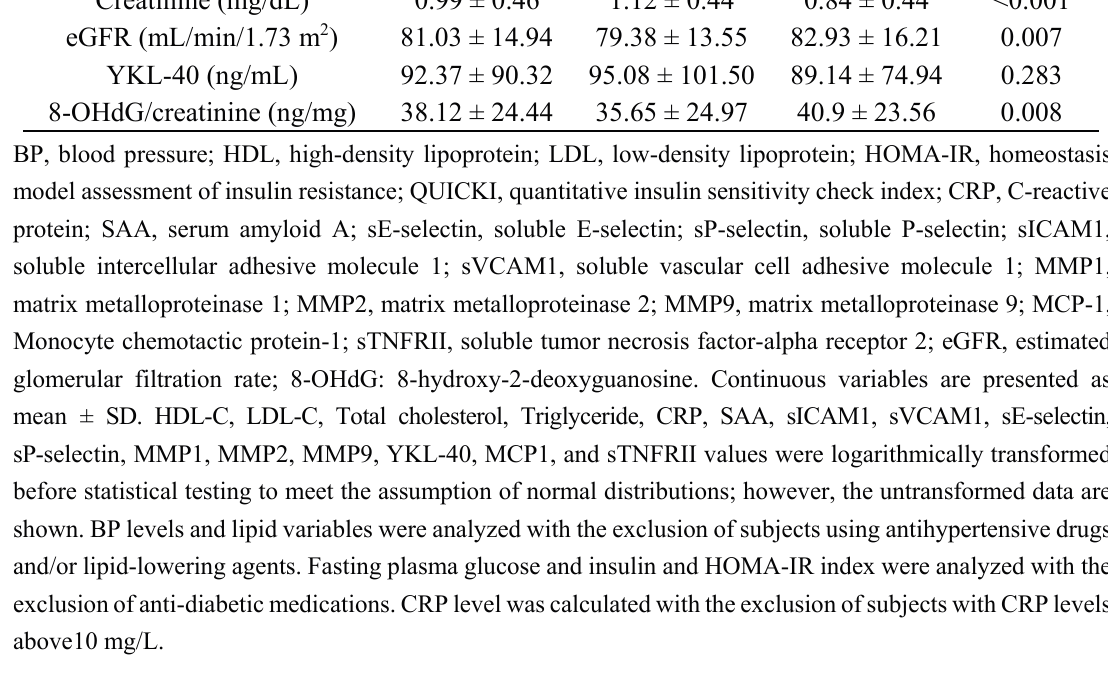
Table 2. Demographics of PAD patients with or without